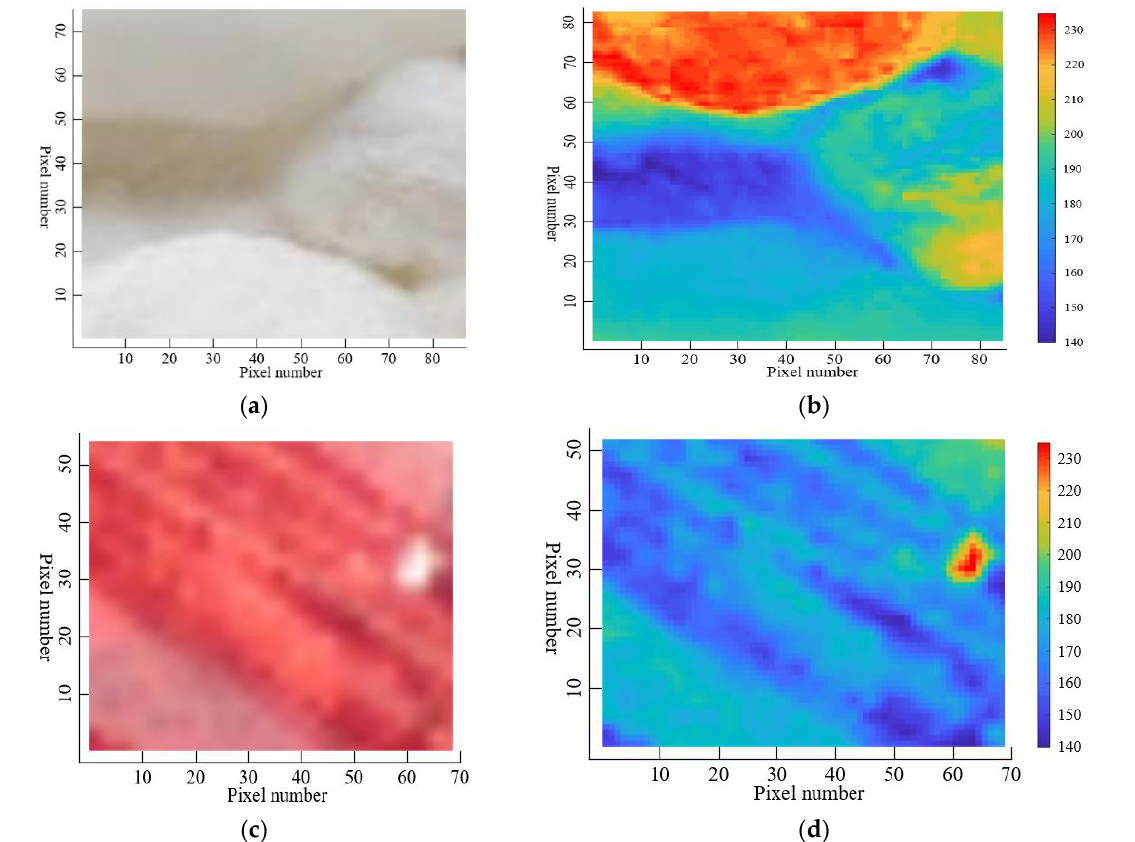
Figure 4. The brightness distribution of rock mineral images. ( a ) Calcite; ( b ) brightness distribution of calcite image; ( c ) cinnabar; ( d ) brightness distribution of cinnabar image.